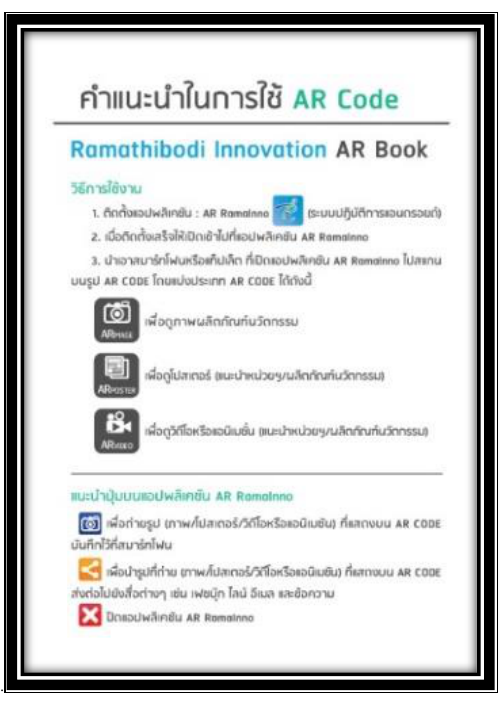
Figure 4 . The instruction on the AR book with the